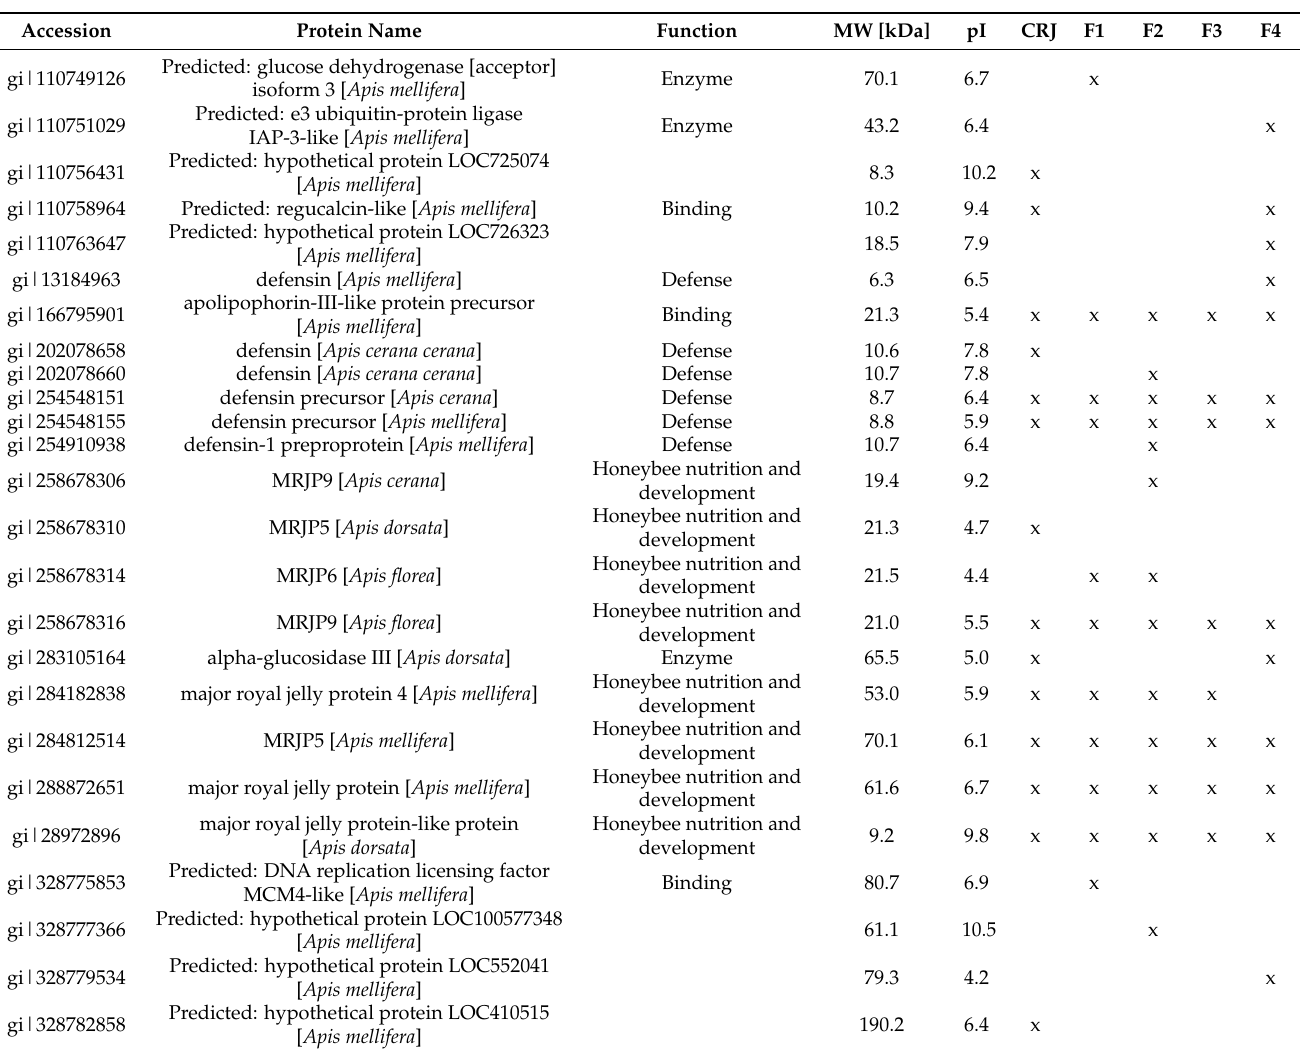
Table 1. List of proteins identified in royal jelly found in: CRJ—“crude” (non-enriched with ProteoMiner TM technique) water extracts of royal jelly; F1, F2, F3, F4—separate fractions obtained from ProteoMiner TM elution with 1 M sodium chloride, 20 mM HEPES, pH 7.4 (F1), 200 mM glycine, pH 2.4 (F2), 60% ethylene glycol in water (F3), and 33.3% 2-propanol, 16.7% acetonitrile (ACN), 0.1% trifluoroacetic acid (TFA) (F4); MW—molecular weight; pI—isoelectric point. Fractions, in which proteins were detected, marked with